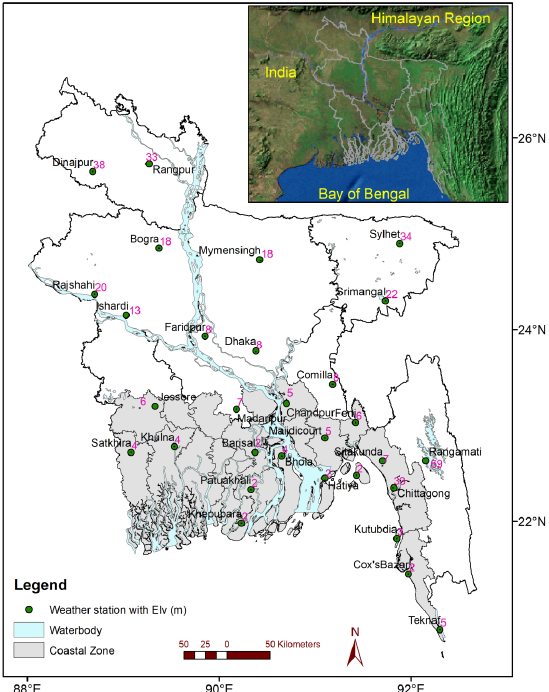
Figure 2. Map of Bangladesh showing coastal (gray color) and inland regions (white color) with location of weather stations. The coastal zone is defined by the Bangladesh Government according to natural systems and events that govern its opportunities and vulnerabilities [76]. The elevation (m) associated with stations (number in pink color) are also indicated in the plot.